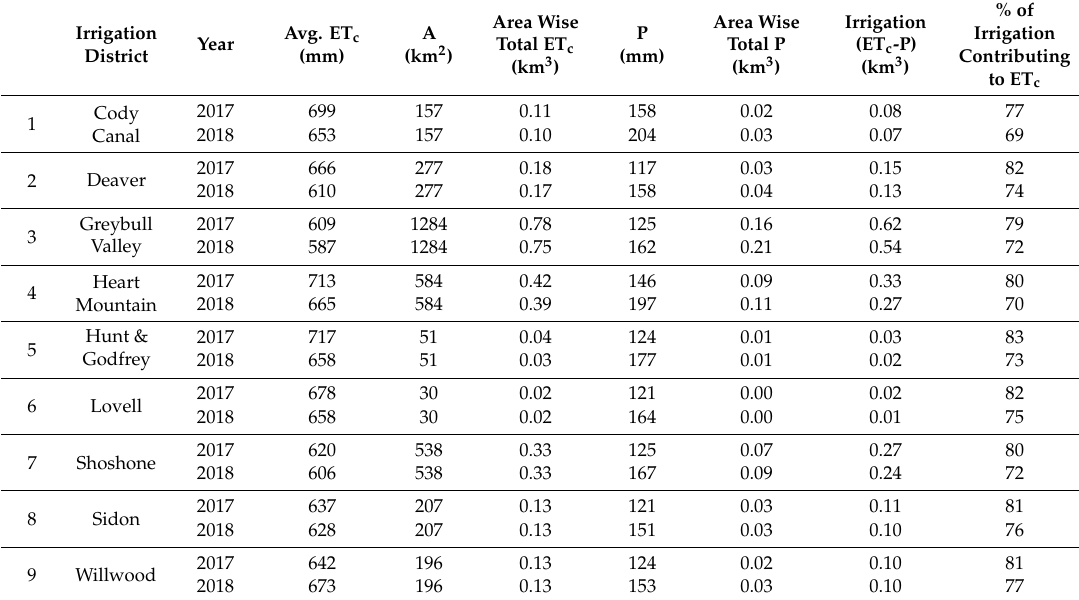
Table 4. Average crop evapotranspiration (ET c ), seasonal precipitation (P), and percent of irrigation-based ET c for 2017 and 2018 crop growing season over nine irrigation districts in the study